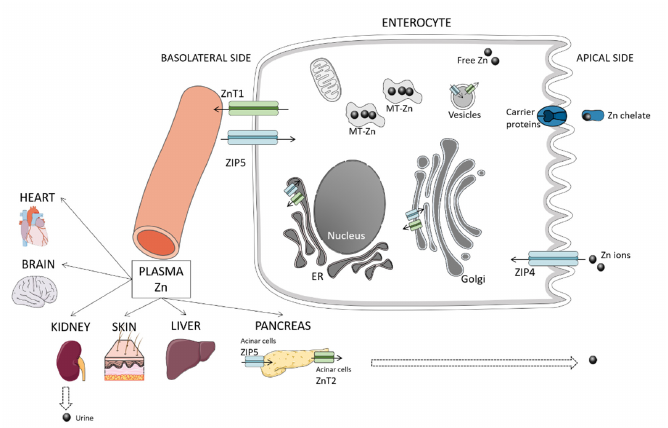
Figure 1. Simplified scheme of zinc metabolism: Intestinal absorption and excretion. ZIP and ZnT transporters of enterocyte membranes and intracellular components are represented in blue and green, respectively. Some of the organs that exchange zinc with plasma pool are represented. Routes of excretion are represented with dashed arrows. ER—endoplasmic reticulum; MT—metallothionein. Own source, based on References [23,24] .